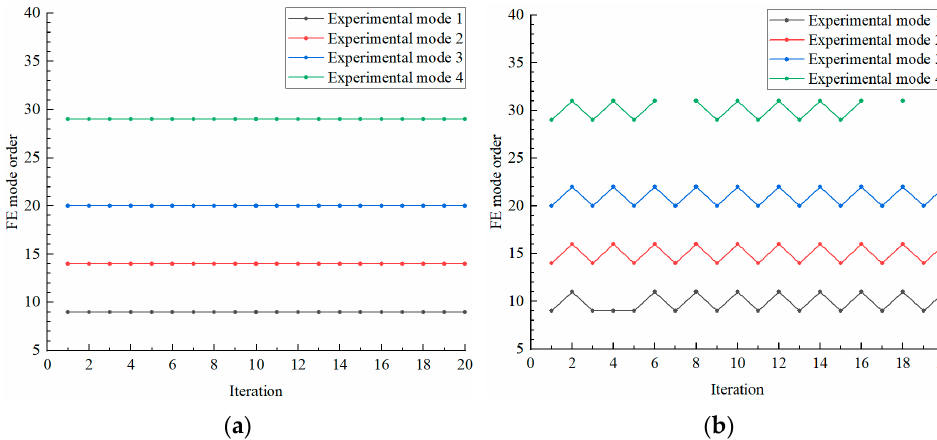
Figure 14. Mode tracking for the first and second approaches. ( a ) Mode tracking for the first approach and ( b ) mode tracking for the second approach.